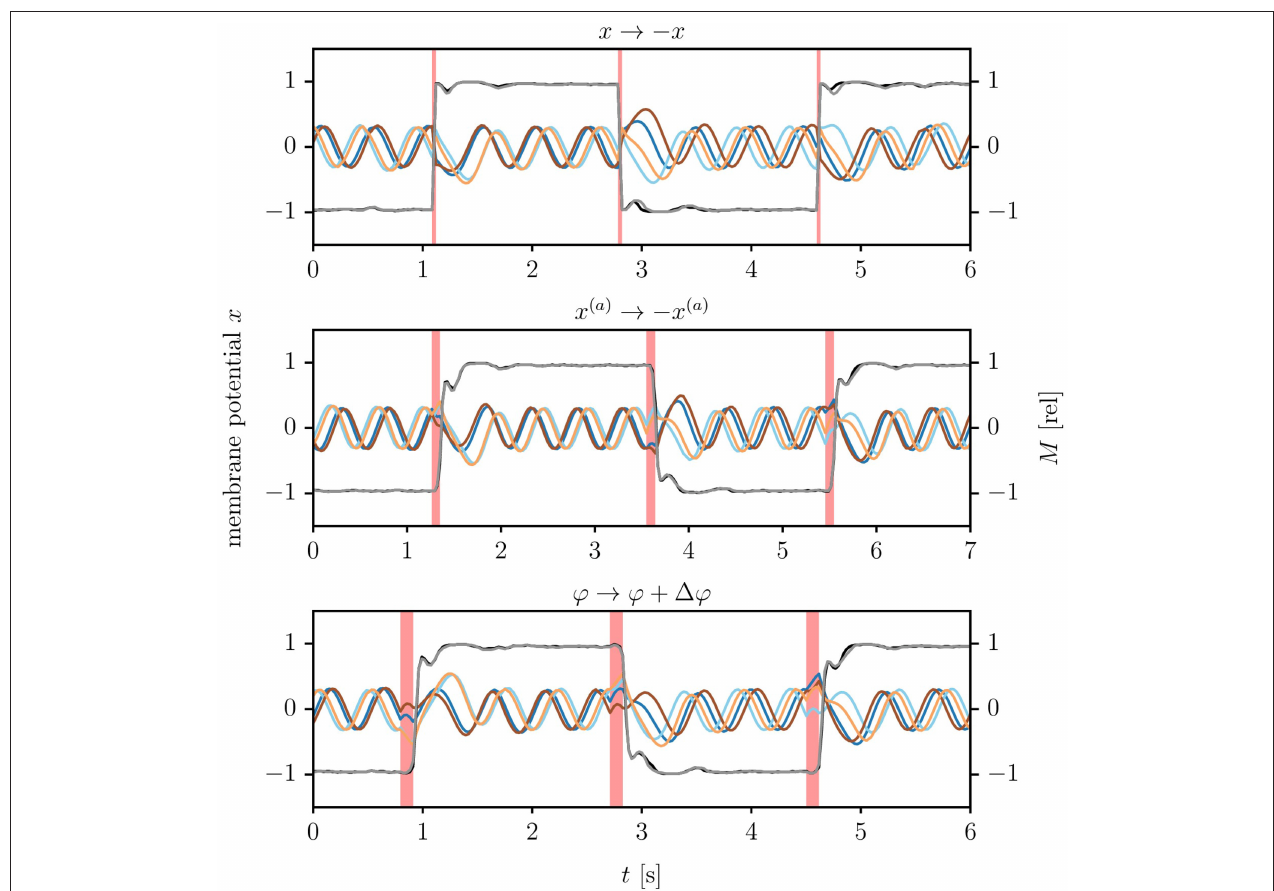
FIGURE 5 | Kick controlling the LEGO Mindstorms robot. Shown are the time series of the membrane potentials (brown/orange and blue/cyan lines for x 1 / x 2 of the left/right wheel), together with the normalized motor control M = ˜ M / ˜ M max (black/gray lines for left/right wheel). The parameters τ = 250ms, k = 8 and a = 4 lead to an angular frequency of ω/ (2 π ) ≈ 2Hz. Top : Inverting all membrane potentials x i , compare (10), with the times indicated by the vertical red lines (click for movie). Middle : Inverting all actual positions x ( a ) i , see (11), for three ticks of the updating cycle (roughly 90ms, as indicated by the red vertical bars). Bottom : Adding a phase shift of 1ϕ = ± 3 π/ 4 to the measured angle of the wheels, see (12). The length of the control signal is here 4 ticks, corresponding to 120ms. Note that the time to settle in the reverse limit cycle exceeds the duration of the kick signal. The relative phase of the left and the right wheel increases considerably after the second reversal.